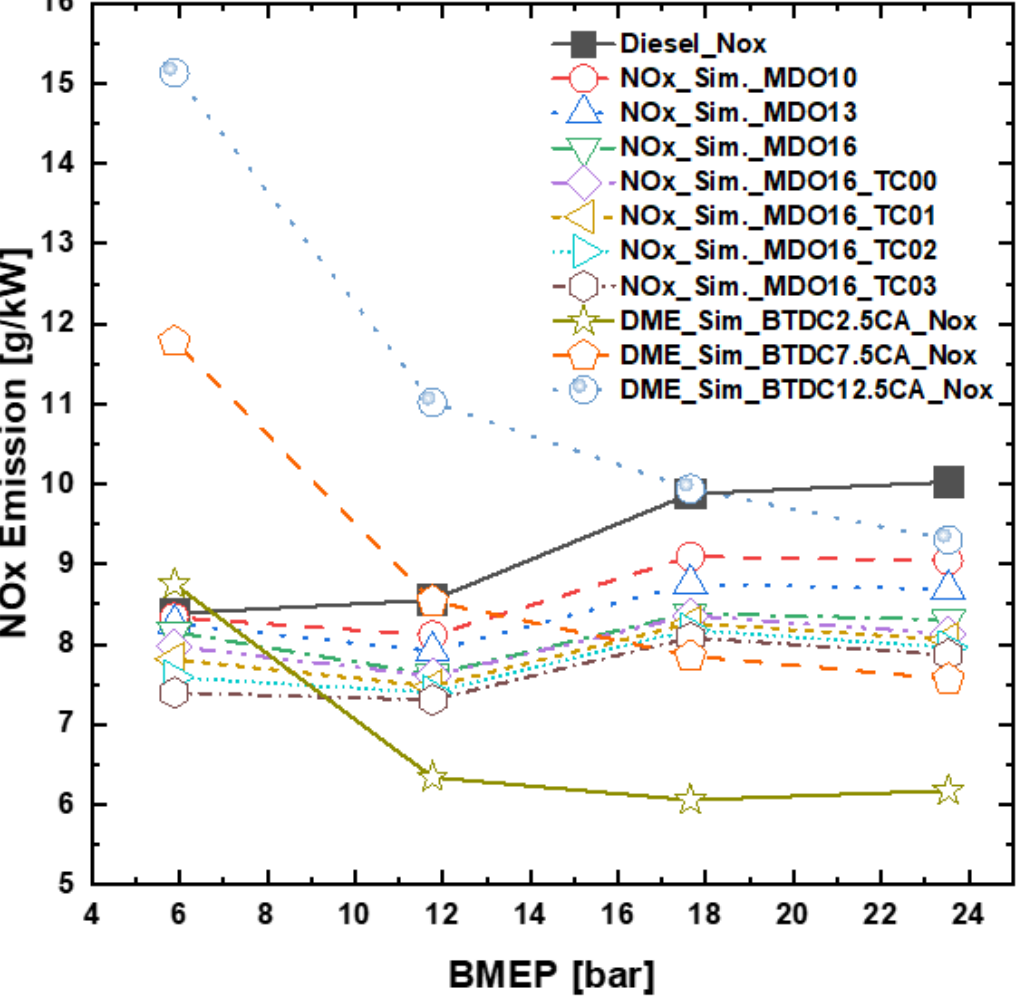
Figure 6. NO x emissions according to MDO, EMDO, and DME fuels in terms of injection timing, turbocharger compression ratio, and moisture concentration.